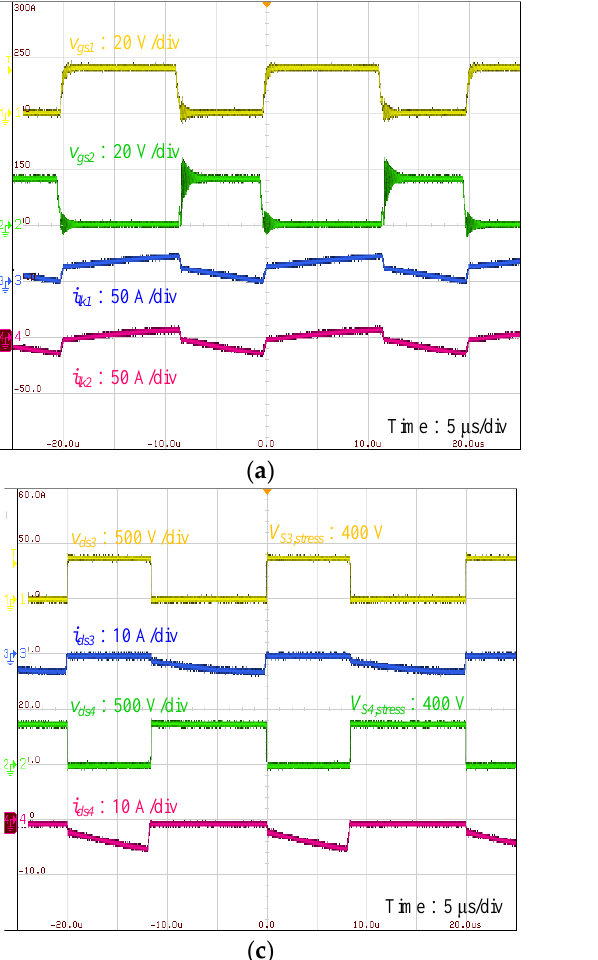
Figure 14. Experimental results of the proposed topology, operated in the step-up mode under the full load (500 W): ( a ) V gs 1 , V gs 2 , i lk 1 , and i lk 2 ; ( b ) V ds and i ds of S1 and S2; ( c ) V ds and i ds of S3 and S4; and ( d ) V C 1 , V C 2 , V C 3 , and V H .